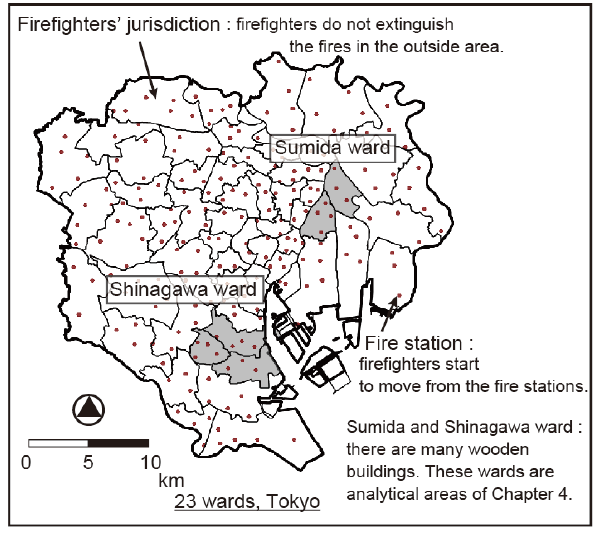
Figure 3. Analytical areas